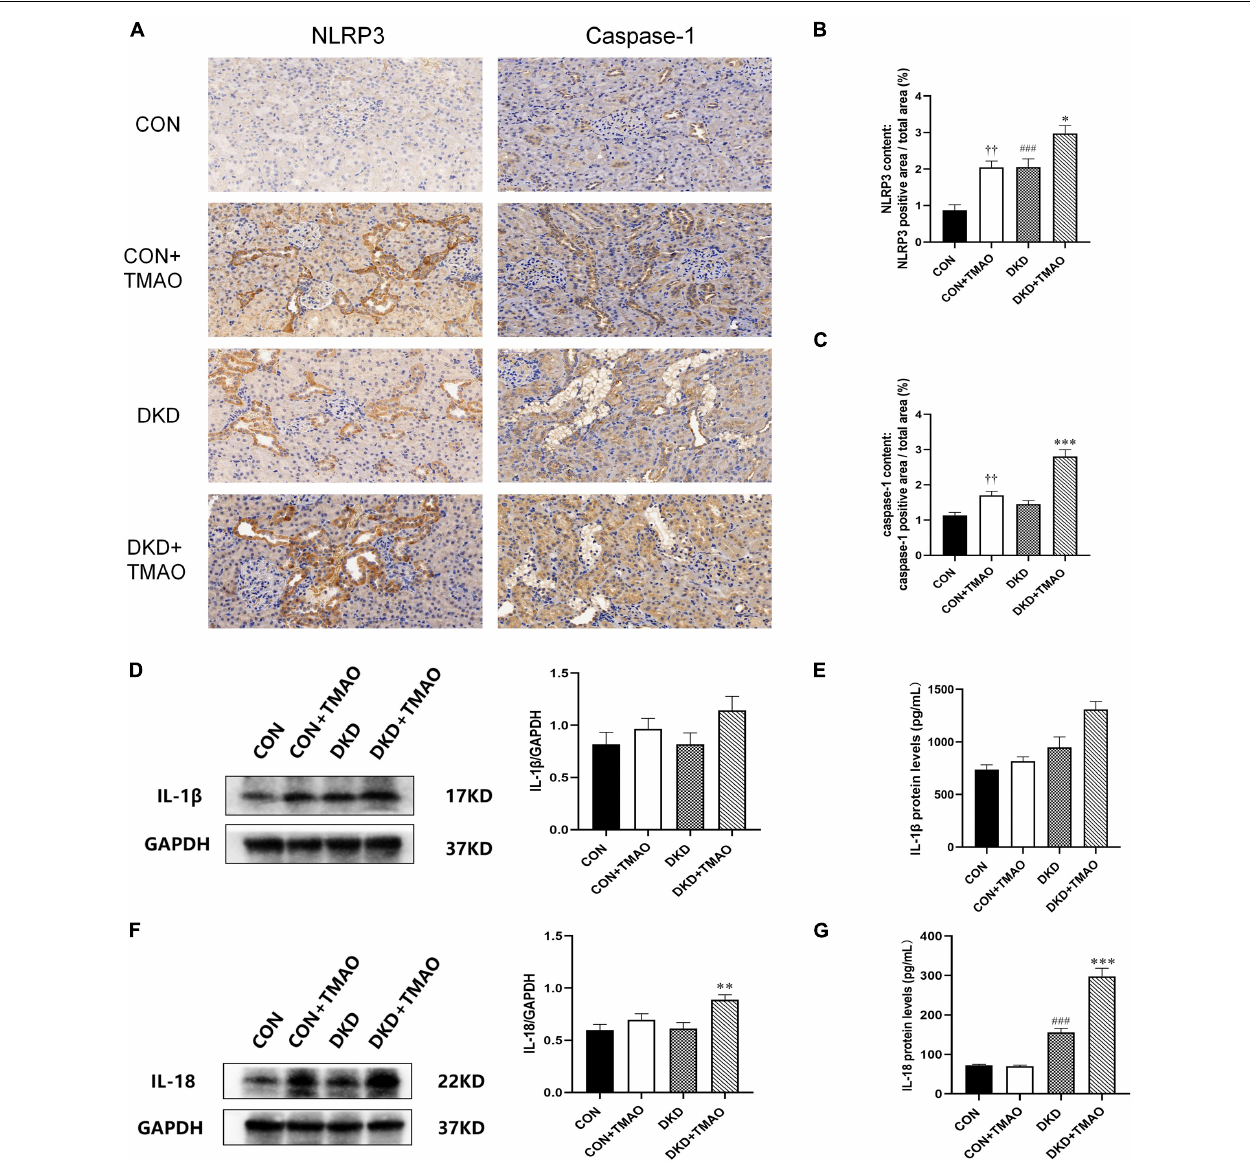
FIGURE 6 | Immunohistochemistry, Western blot and ELISA results of NLRP3 inflammasome in rats. (A) Immunohistochemistry results of NLRP3 and caspase-1 in rats. Relative percentages of (B) NLRP3 and (C) caspase-1 positive area to total area. (D) Western blot and (E) ELISA results of IL-1 β in kidney of rats. (F) Western blot and (G) ELISA results of IL-18 in kidney and serum of rats. Data are presented as mean ± SEM ( n = 3–8 for each group). †† P < 0.01 vs. CON, ### P < 0.001 vs. CON, * P < 0.05, ** P < 0.01, *** P < 0.001 vs.